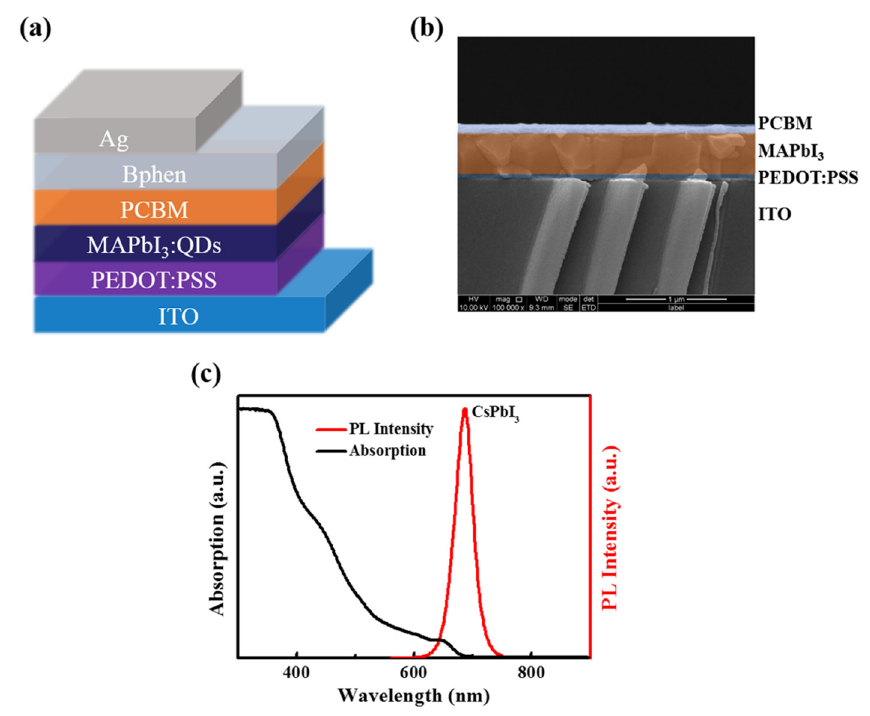
Figure 1. ( a ) The device structure of PSCs; ( b ) cross-sectional image SEM of the device. ( c ) UV-vis absorption spectrum and PL spectrum of CsPbI 3 QDs.